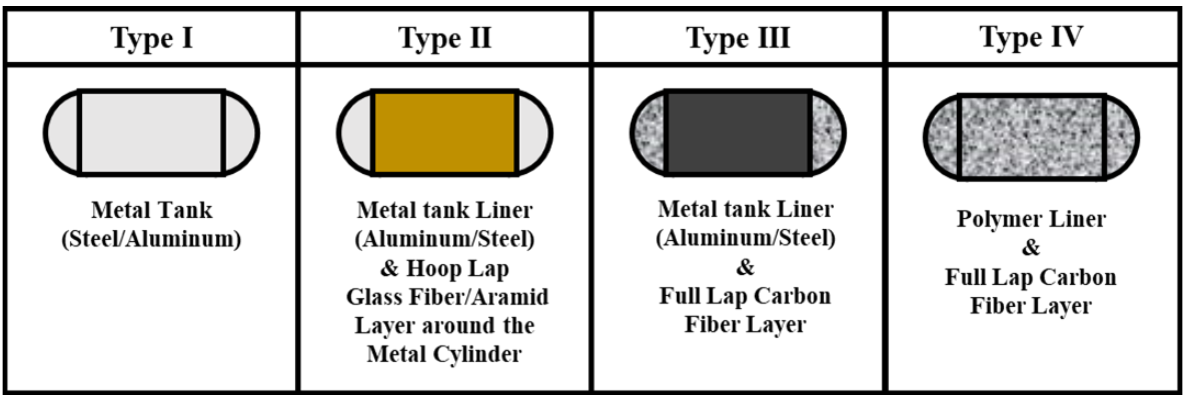
Figure 6. Hydrogen density levels as a function of pressure and temperature. Data processed from [40].